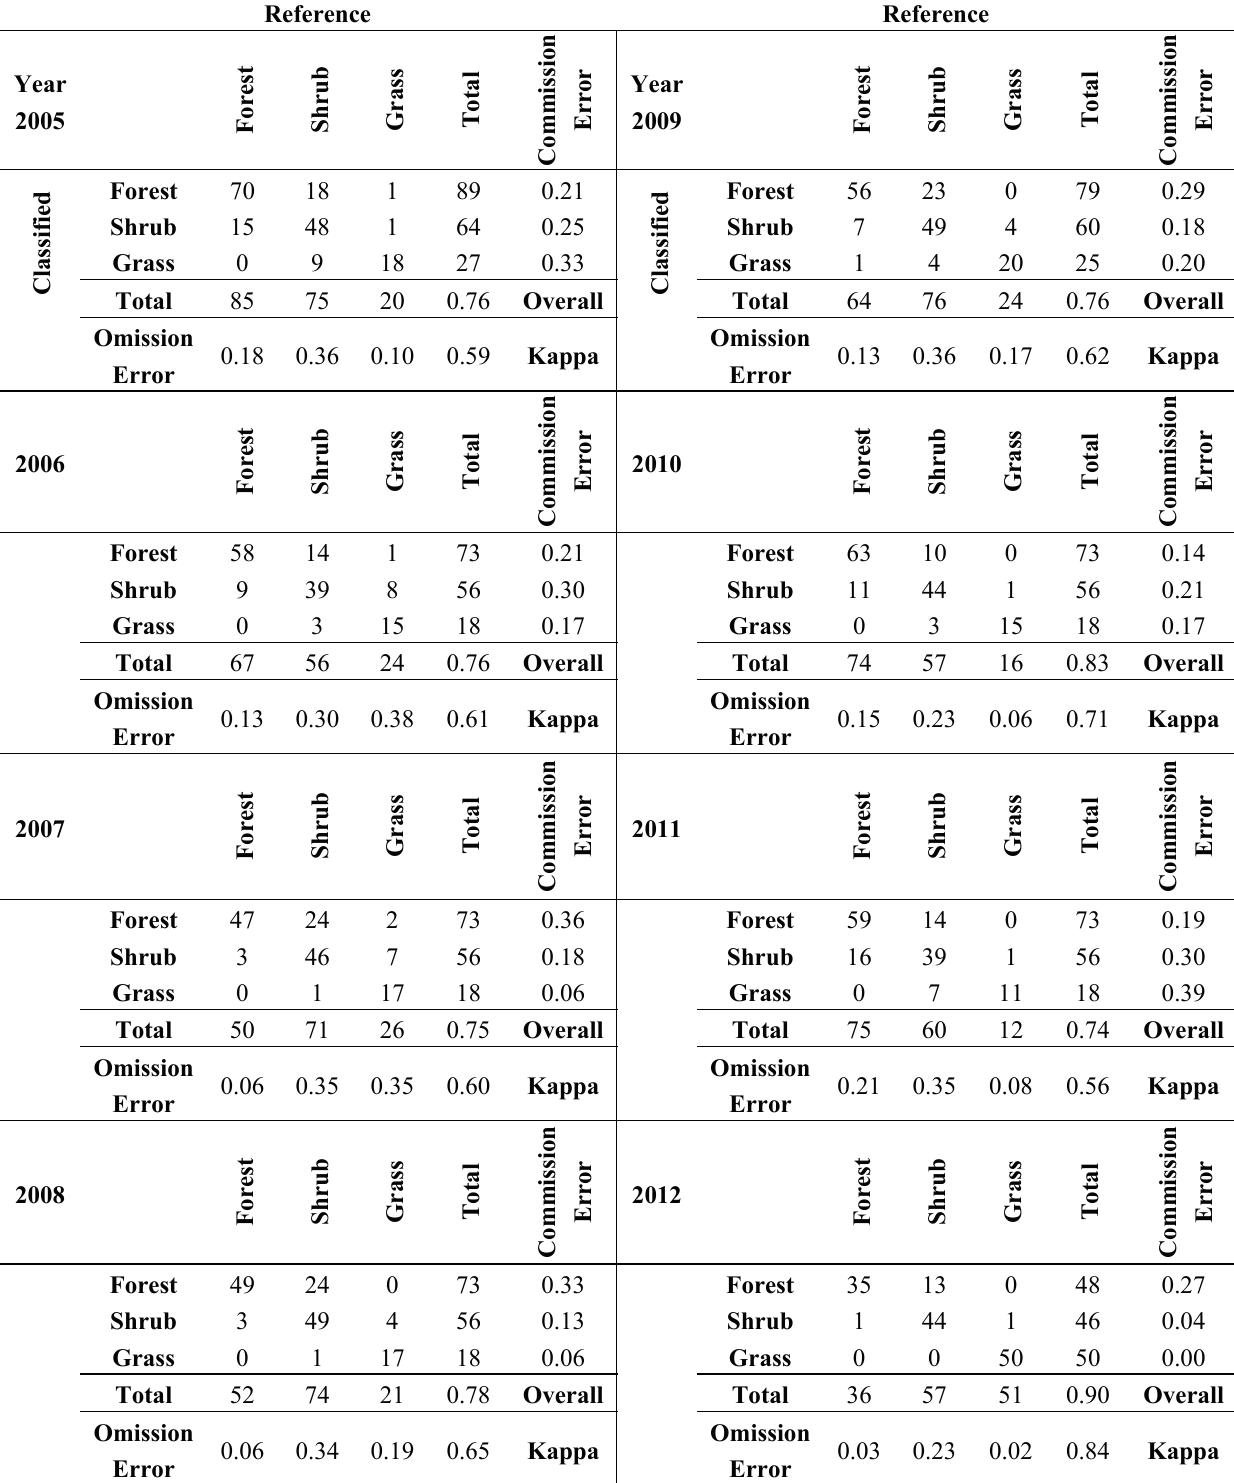
Table 5. Error matrices for each year. The rows represent classified pixels, and columns represent the spatially corresponding validation sites. Omission error is the proportion of incorrectly classified validation sites. The commission error is the proportion of pixels incorrectly classified. Overall accuracy is the total number of correctly classified pixels divided by the total number of pixels. The Kappa statistic is a metric that accounts for the overall totals, as well as individual class